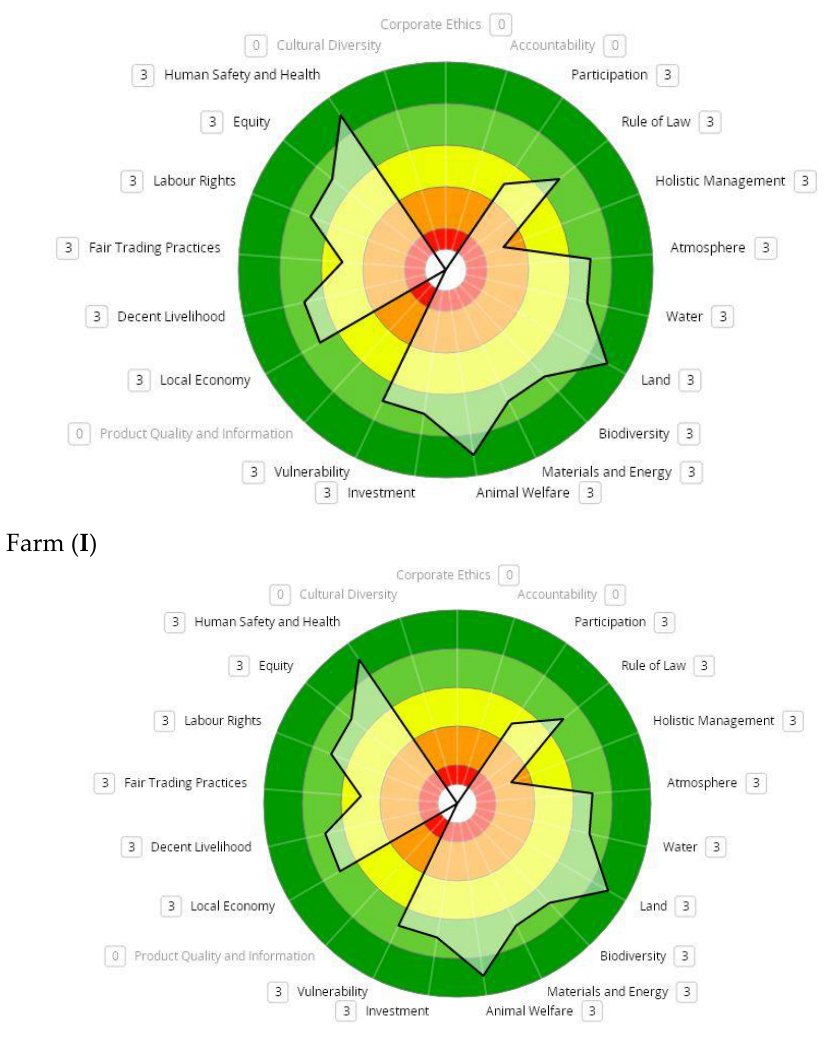
Figure 2. Farm ( A – J ) Results of the sustainability assessment of organic livestock farming with SAFA, by individual indicator and production unit.